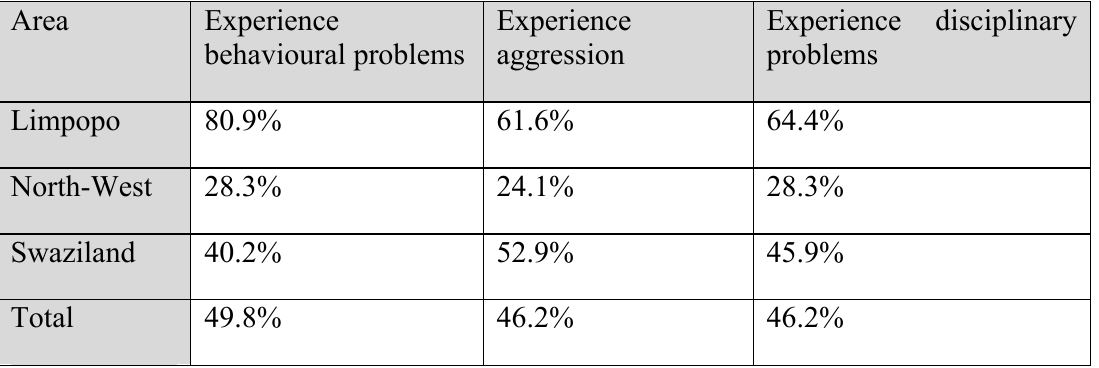
Table 6. Teachers’ perception of orphans manifesting behaviour